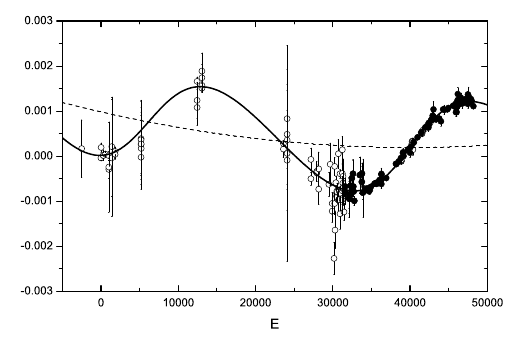
Figure 1: O-C diagram of HS 0705+6700. Dots re- fer to our new data obtained after Qian et al. (2009), and open circles to the other data. Dashed line refers to the continuous increase in the period, while the solid line to a combination of the period increase and a cyclic change.